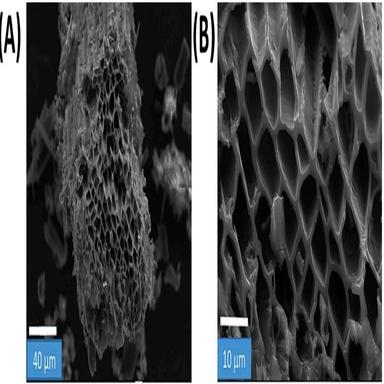
SEM images of activated carbon material activated with a 1:5 ratio of KOH, depicting the material at scales of (A) 40 nm and (B) 10 nm.